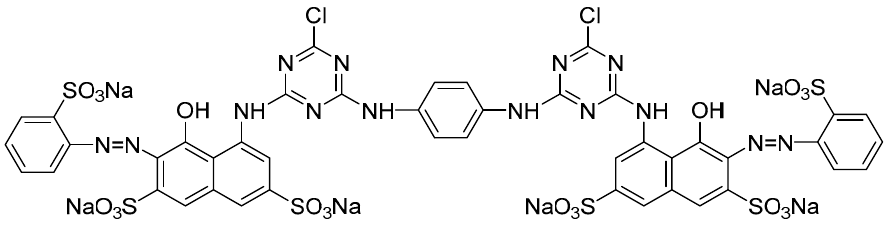
Figure 1. Molecule structure of C.I. Reactive Red 120.